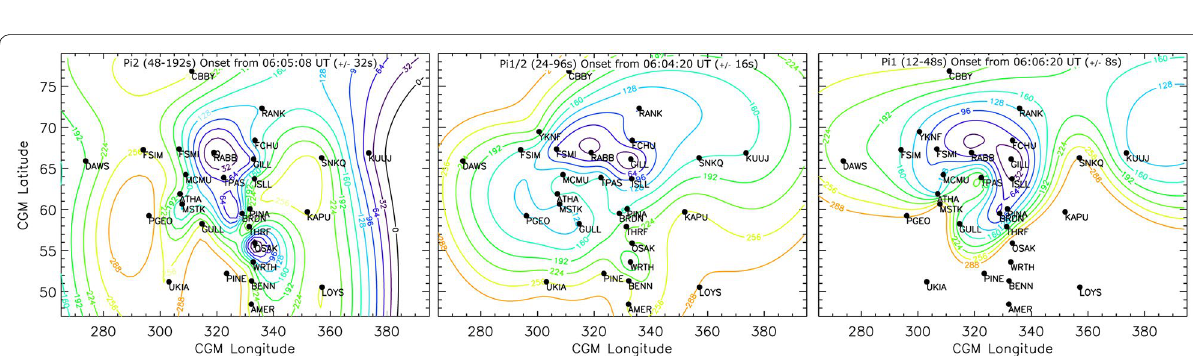
Fig. 4 A minimum curvature fit for the onset times in the (left) j as derived at each magnetometer station. Coloured, annotated contours represent the onset times, and the contours of each panel are separated by 32 s to show consistent onset contours across wave bands. The maximum error in this fit is of the order of seconds and hence represents the actual onset time at each station within stated errors. Stations that did not record an onset in the right-hand panel at lower latitudes are not used in this